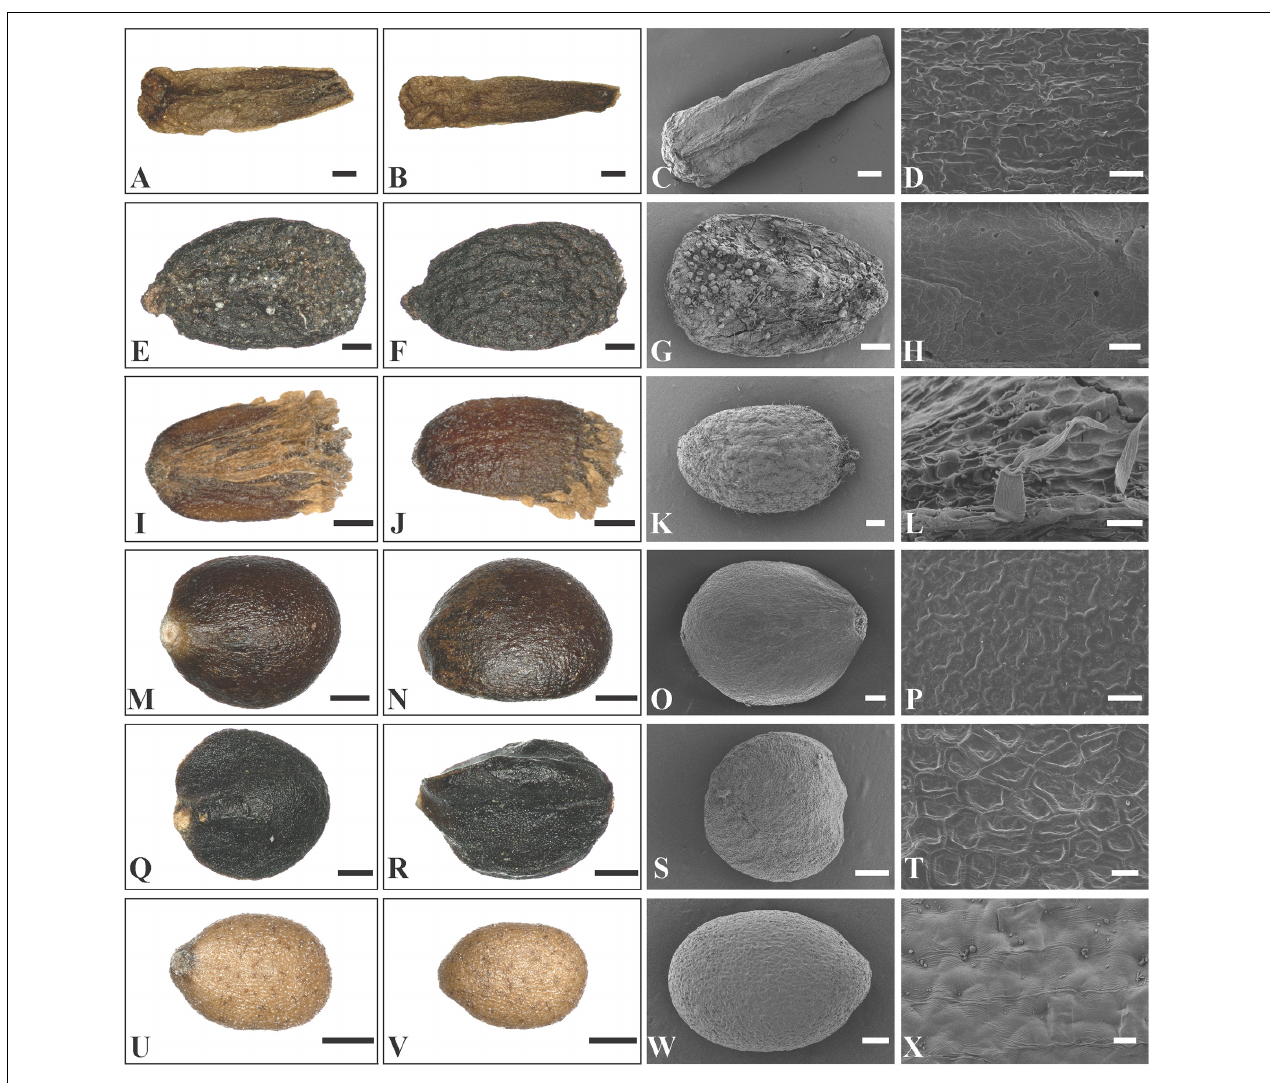
FIGURE 7 | LM and SEM micrographs of mericarps of Leucosceptrum, Eurysolen , Achyrospermum, Craniotome , Paralamium and Colebrookea. (A–D) Leucosceptrum canum ( Li Yongliang, YDDXS00058 ), (E–H) Eurysolen gracilis (Chen Yaping and Jiang Lei, EM1436 ), (I–L) Achyrospermum wallichianum ( Liu et al., 16CS11840 ), (M–P) Craniotome furcata ( Liu et al., 16CS11942 ), (Q–T) Paralamium griffithii ( Liu et al., 7859 ), (U–X) Colebrookea oppositifolia ( Li Yongliang, YDDXS1001 ). — Scale bars: (A–C,I,J) 400 µ m; (D,H,L,P) 20 µ m; (E–G,K,M,N,Q,R,U,V) 200 µ m; (O,S,W) 100 µ m; (T,X) 10 µ